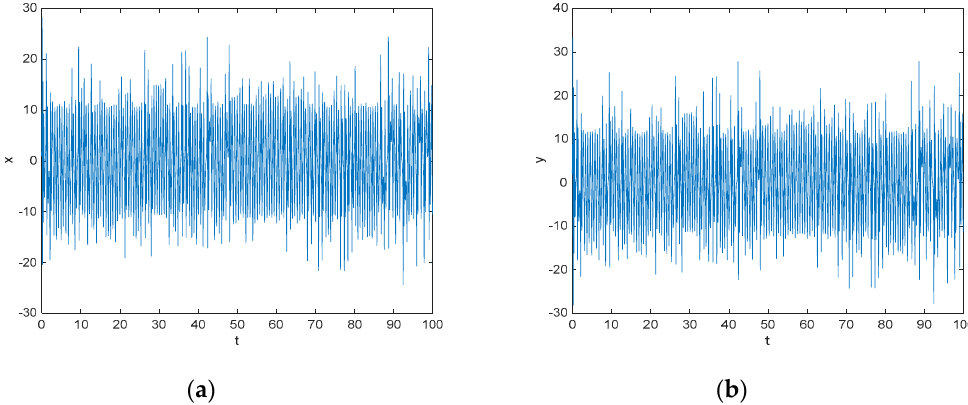
Figure 1. Phase space diagram of x-y plane. ( a ) α = 0; ( b ) α = 0.5; ( c ) α = 0.8; ( d ) α = 1.